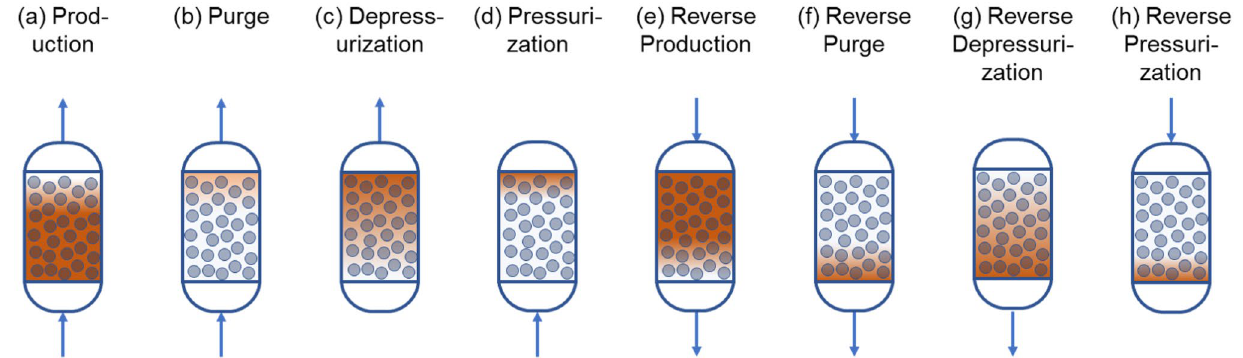
Figure 3. Graphical depiction of 8 process operation modes that constitute a PSA-based MOC cycle. The blue circles denote the adsorbent particles whereas the darker orange shade represents the part of the adsorbent column saturated with oxygen